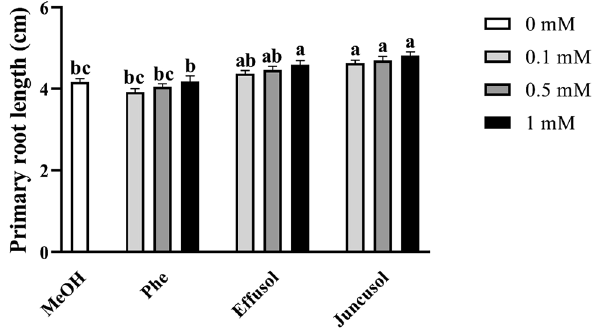
Figure 5. Primary root lengths of seedlings treated with Phe, effusol, and juncusol at different concentrations compared to MeOH. Data are presented as the mean ± SE (n = 30). Different letters indicate significant differences between the values of the treatments (P < 0.05) analysed by Tukey’s post-hoc test. Primary root lengths were analysed by ImageJ software ver. 1.52a (National Institute of Mental Health, Bethesda, Maryland, USA) (http:// imagej. nih. gov/